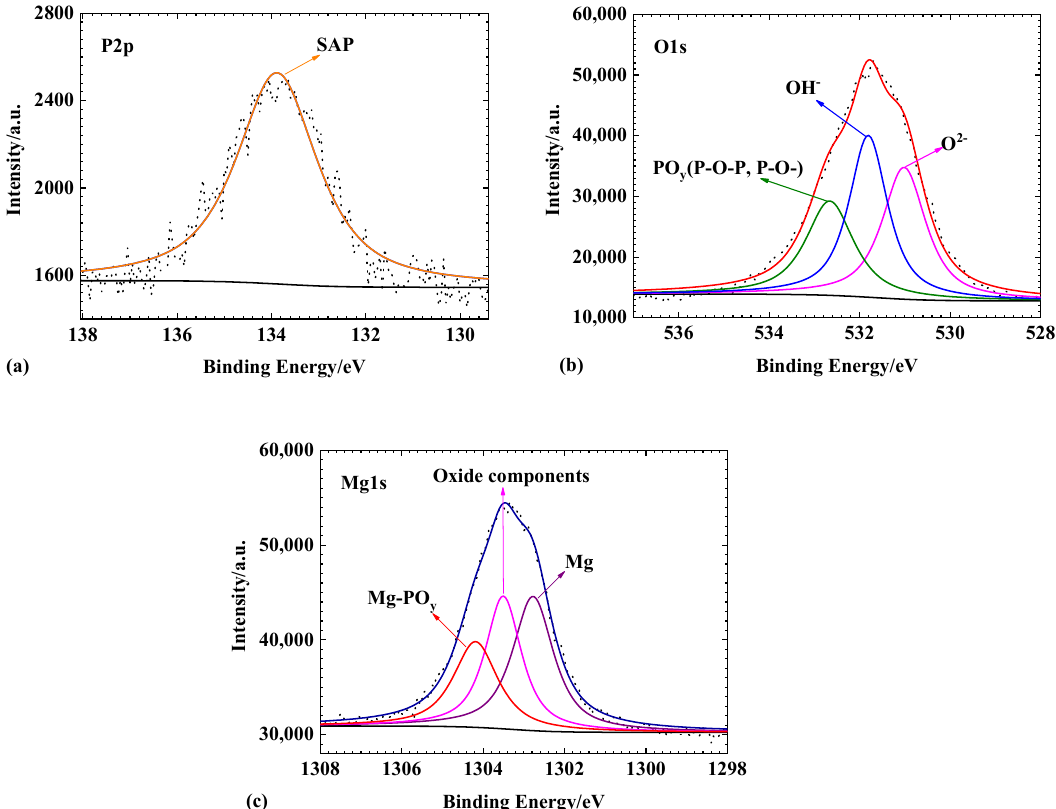
Figure 10. X-ray photoelectron spectroscopy (XPS) survey spectra of the substrate surface underneath SAP-MRP after 339 days of immersion in the simulated acid rain solution: ( a ) P 2 p , ( b ) O 1 s and ( c ) Mg 1 s